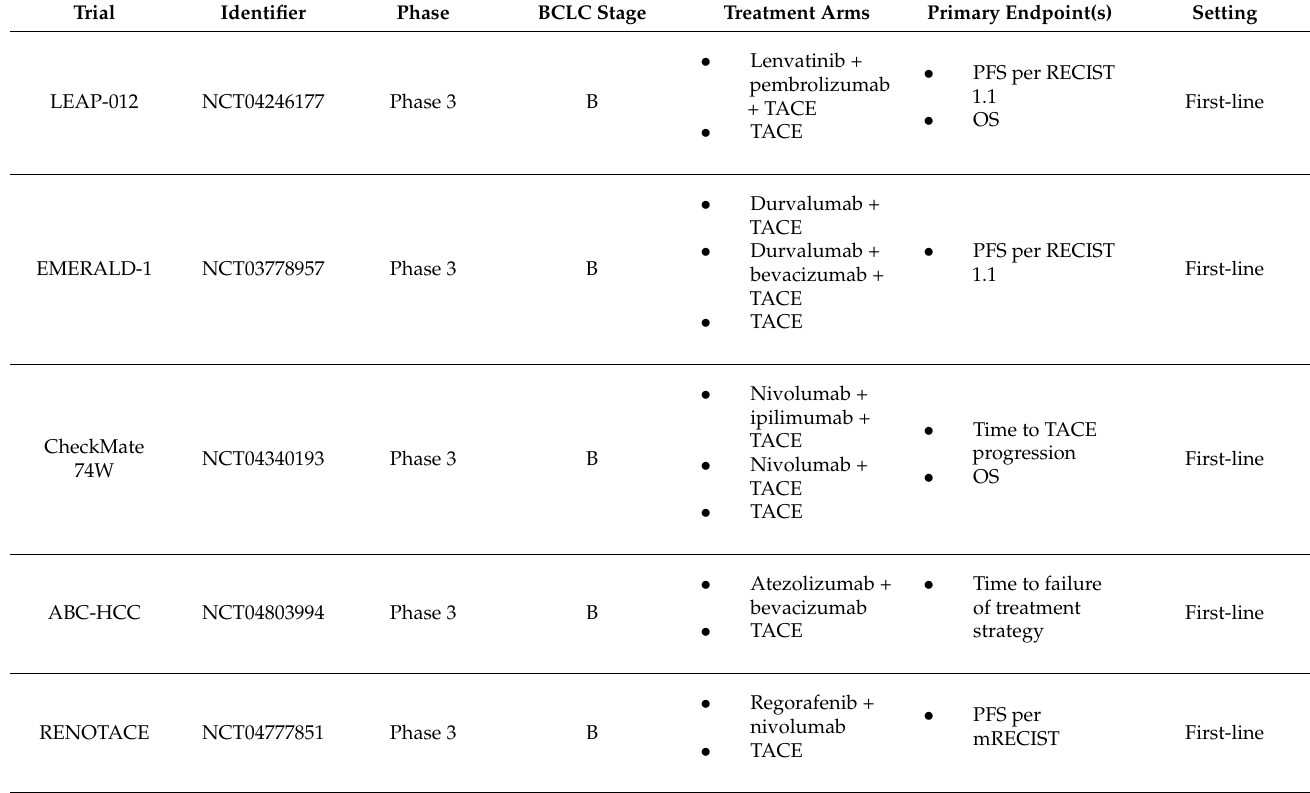
Table 3. Current clinical trials combining or comparing systemic treatments with